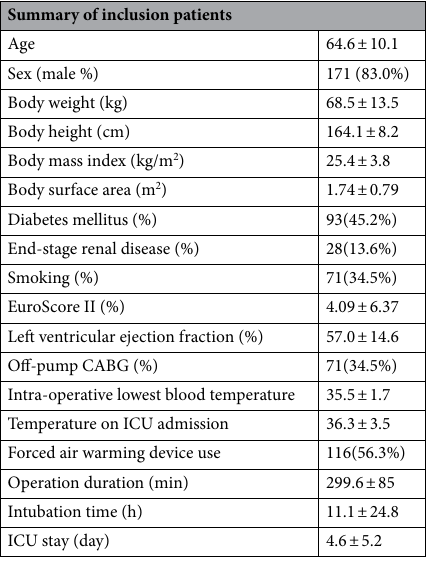
Table 1. Baseline data in elective coronary artery bypass grafting surgery patients. Values are mean ± SD or number (proportion). CABG coronary artery bypass grafting, ICU intensive care unit.